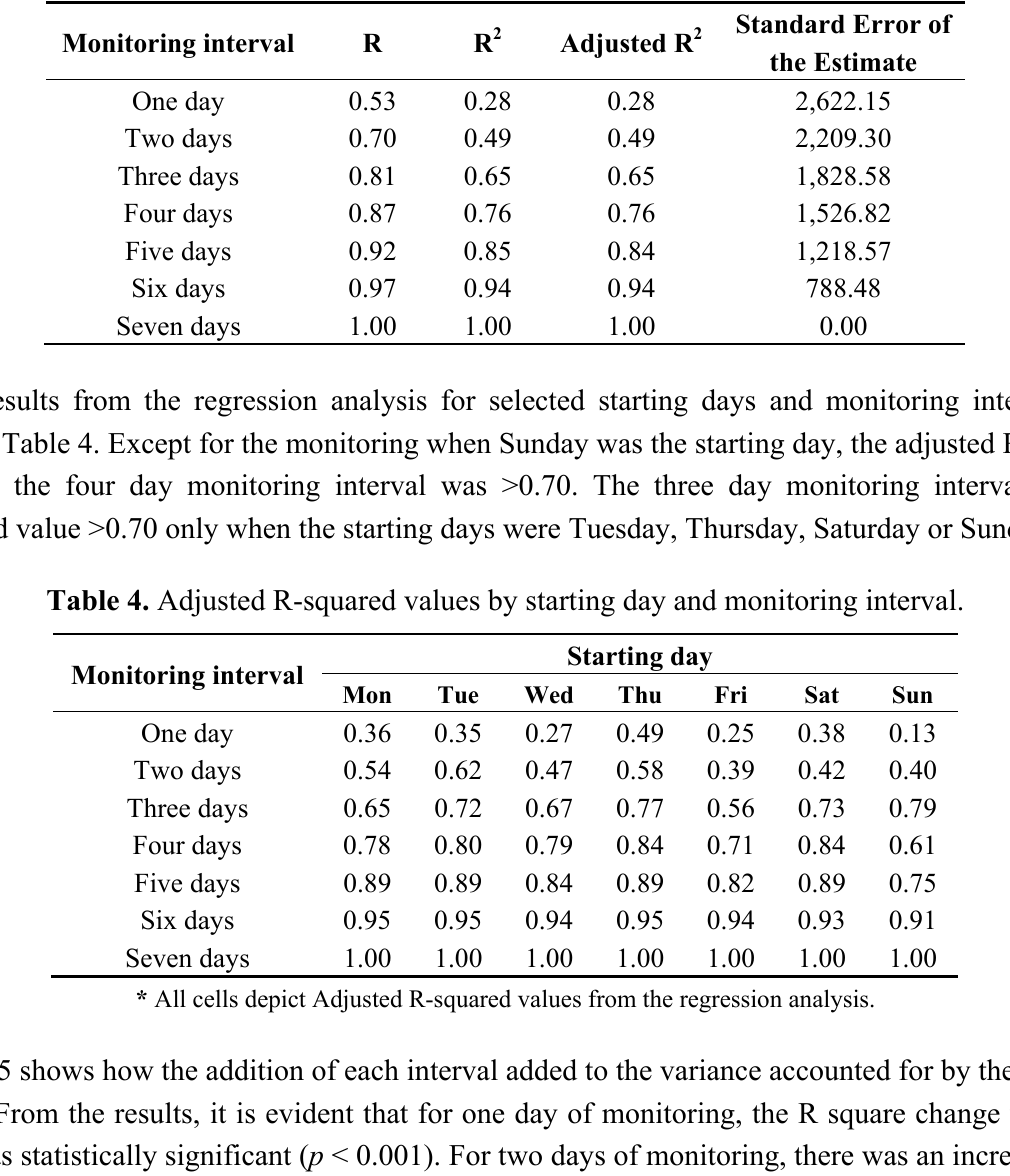
Table 3. Regression statistics for selected monitoring intervals.